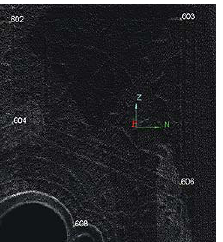
Figure 14. Control points extracted from the point clouds for image